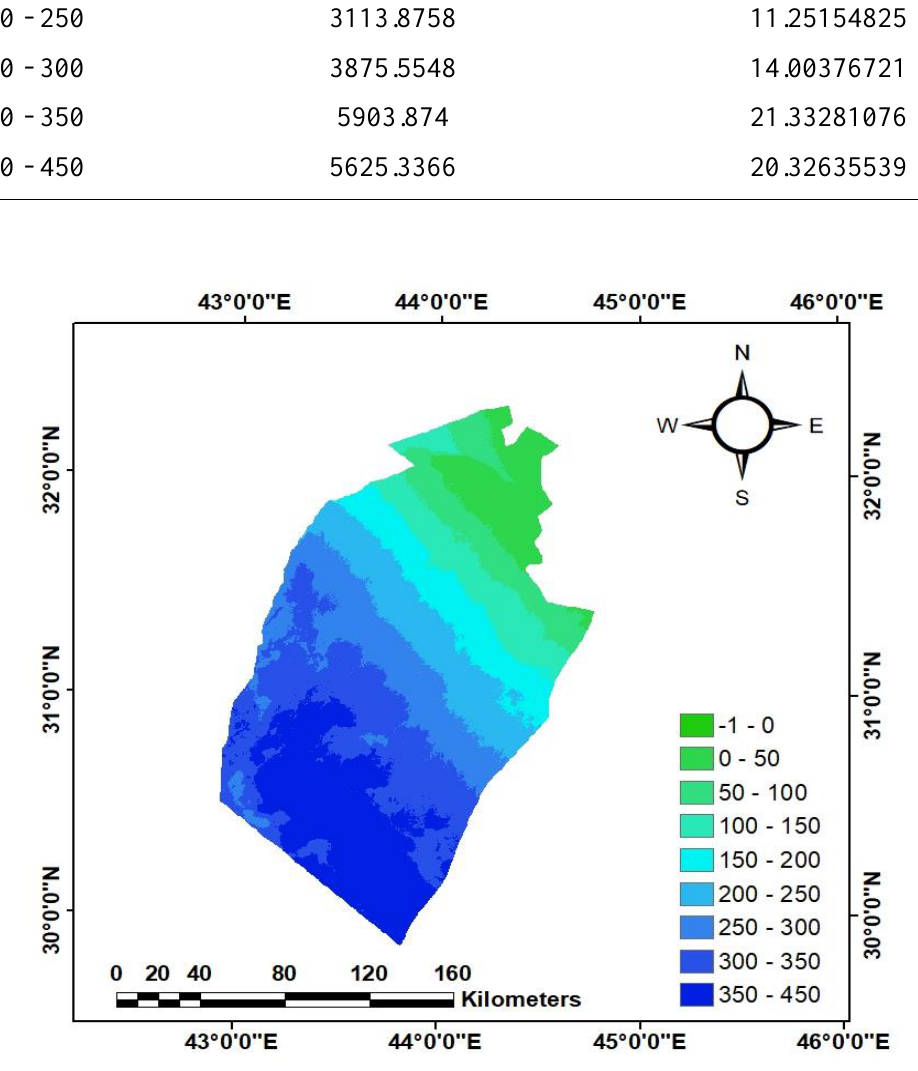
Fig. 3. The Digital Elevation Model (DEM) of An Najaf